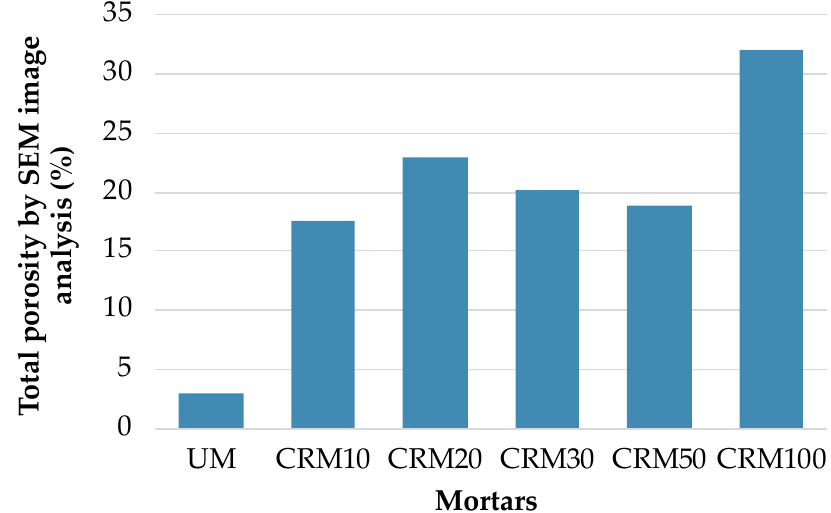
Figure 13. Percentage of total porosity of CRMs by SEM image analysis.